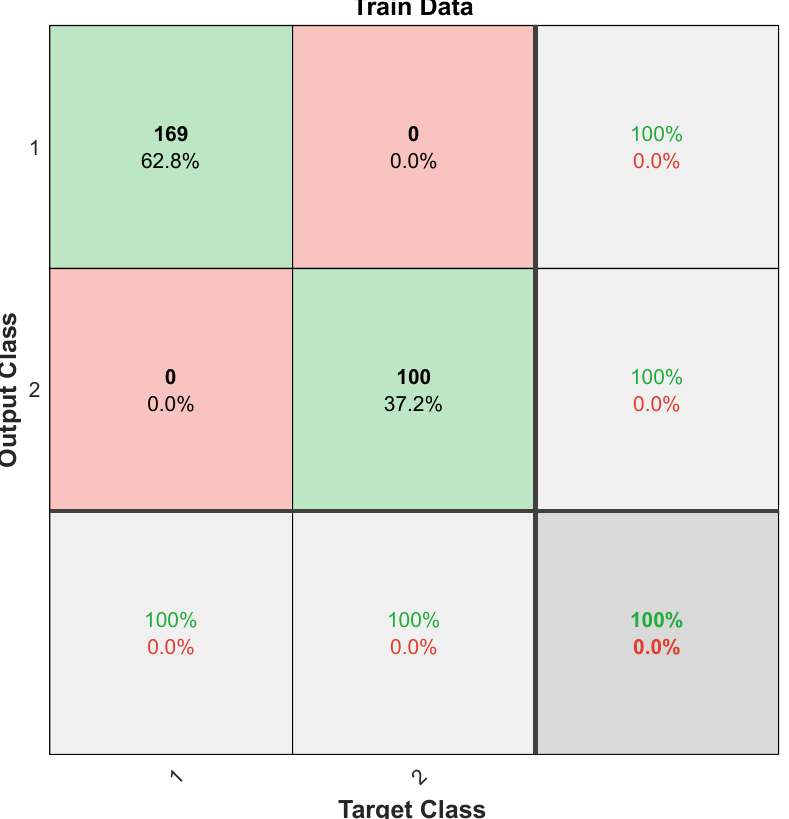
Figure 2. Confusion matrix for training data.